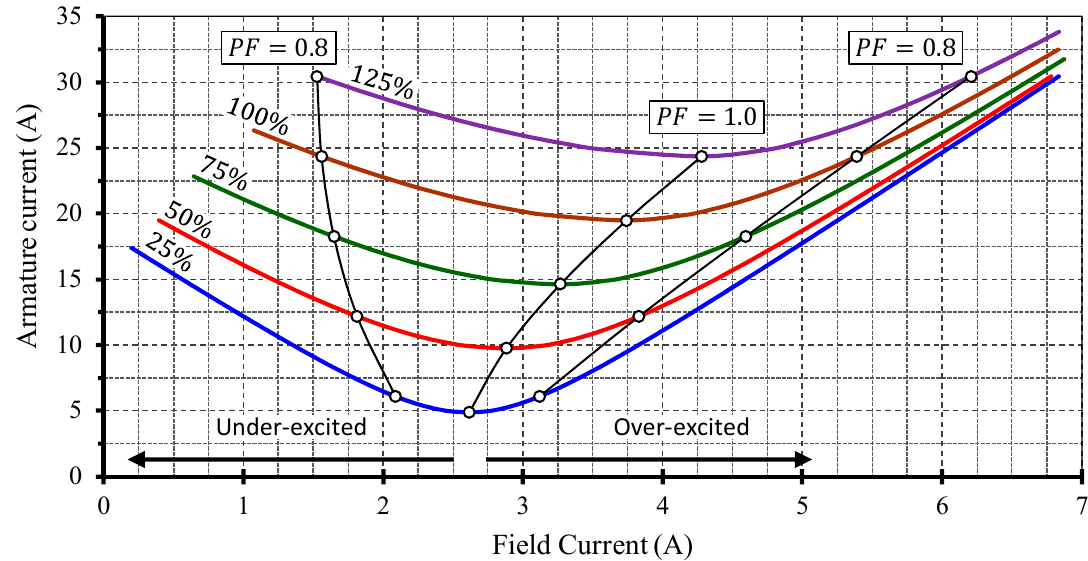
Figure 8. “V” curves of the resulting generator corresponding to different load conditions.